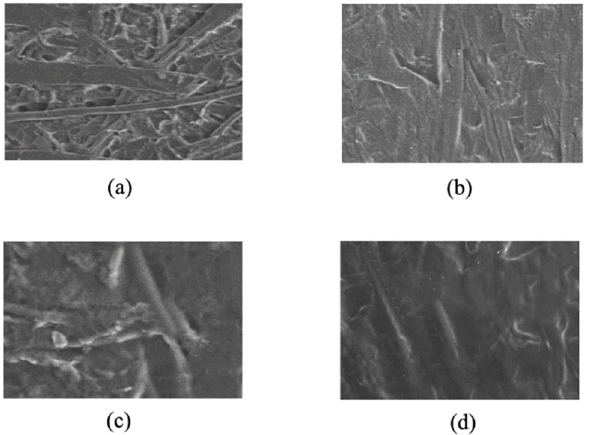
Figure 13. SEM views of the uncoated and coated packaging paper. ( a ) is packaging base paper and the magnification is 200; ( b ) is the paper with coating amounts of 1.51 g/m 2 and the magnifica- tion is 200; ( c ) is the paper with coating amounts of 2.55 g/m 2 and the magnification is 400; ( d ) is the paper with coating amounts of 3.60 g/m 2 and the magnification is 400.